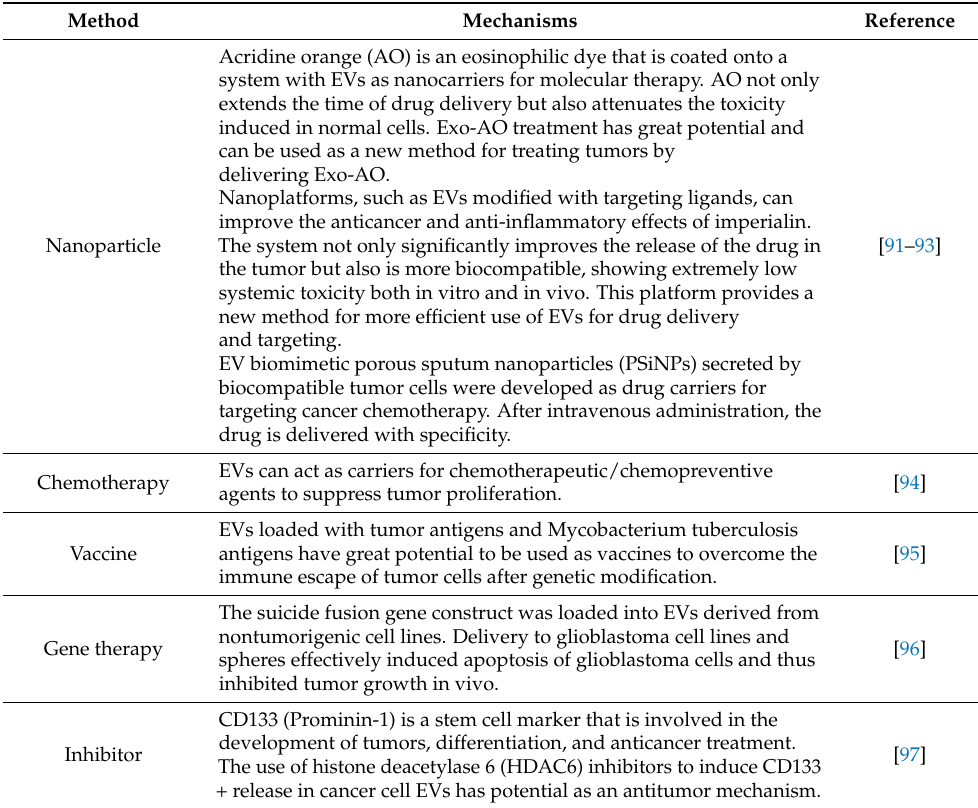
Table 5. The therapeutic applications of EVs in